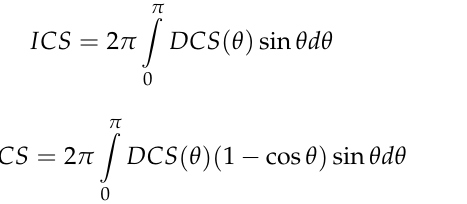
Figure 1. Angle differential cross-sections for elastic electron scattering from methane molecule, for six incident electron energies, from 50 eV to 300 eV. The present results include experiment (blue circles), relative flow absolute data (red stars), theory with molecular effects (full line) and simple sum theory (dashed line). Previous results, tabulated in Table 1, are also shown for the sake of comparison.